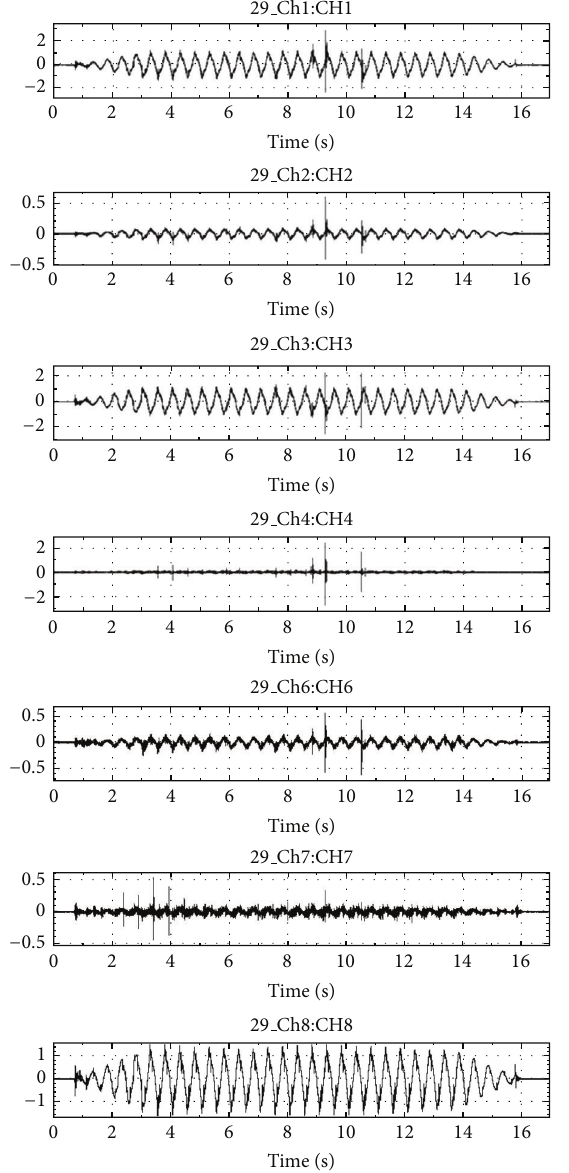
Figure 24: Microseism signals from different channels in working condition 29 (CH indicates the sensors’ serial